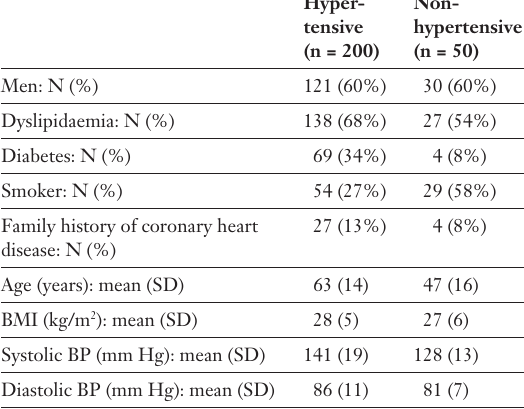
Concordance be- tween physicians’ and Framingham es- timation of risk cate- gory for both hyper- tensive (n = 200) and non-hyperten- sive patients (n =